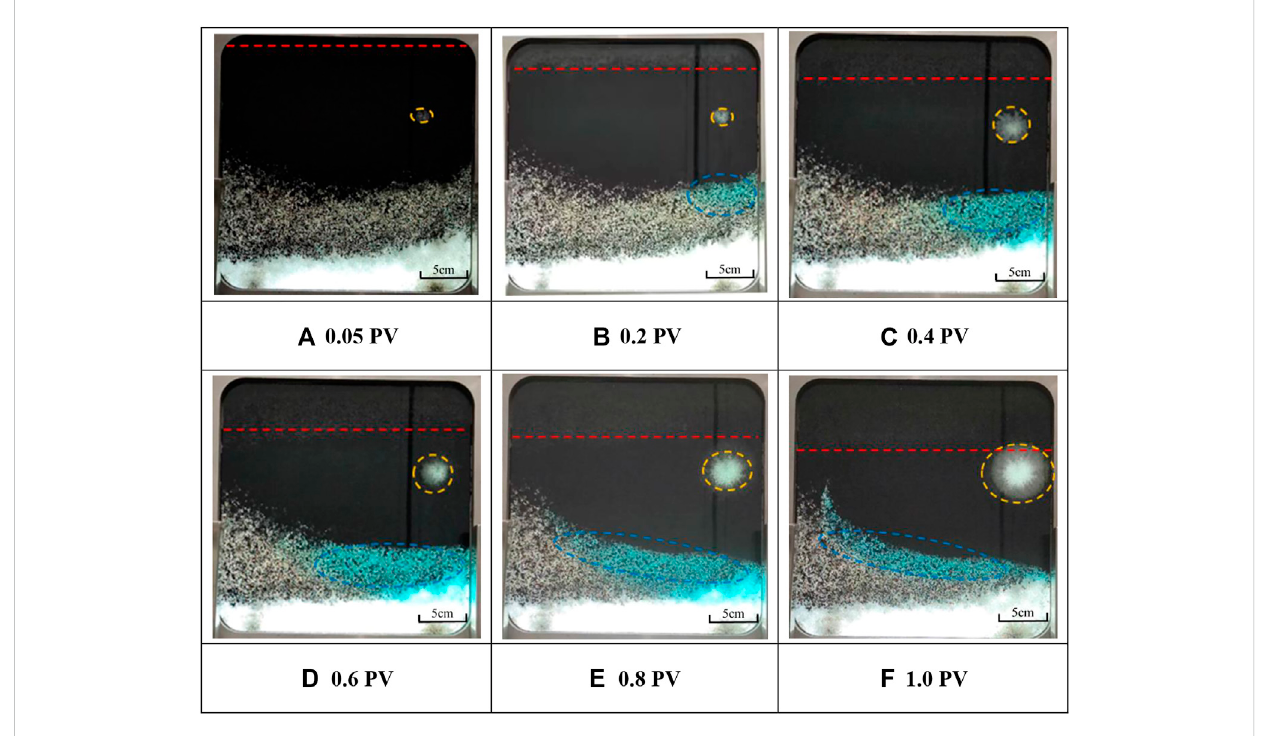
FIGURE 11 Results of nitrogen foam fl ooding at different stages. (A) 0.05 PV, (B) 0.2 PV, (C) 0.4 PV, (D) 0.6 PV, (E) 0.8 PV, (F) 1.0